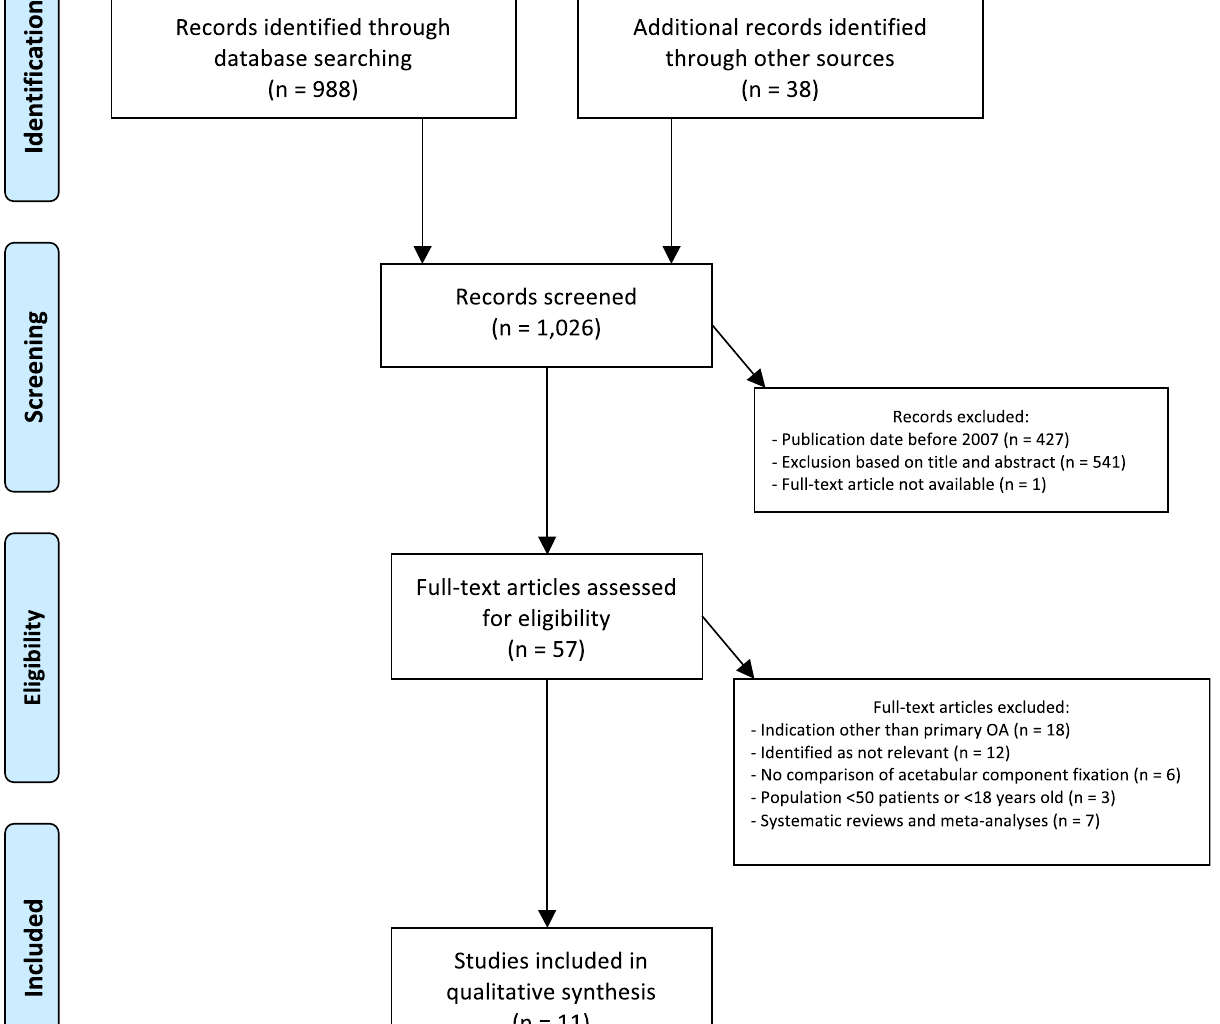
Figure 1. PRISMA Flow Diagram for selection and inclusion of relevant